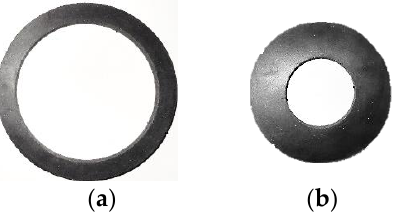
Figure 2. Component test samples used to determine material parameters: ( a ) O-ring tension test and ( b ) O-ring compression test.